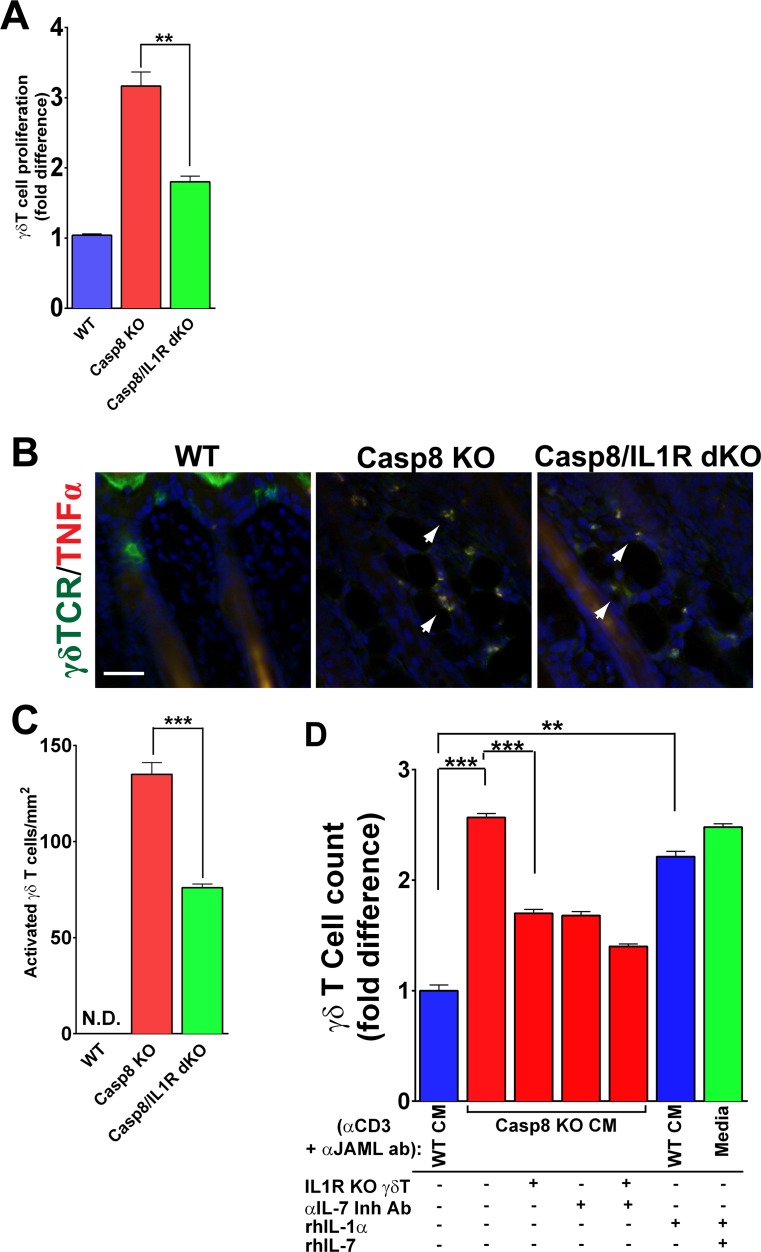
IL-1 signaling contributes to γδT-cell proliferation in the caspase-8 cKO skin.(A) Quantification of γδT-cell proliferation. The numbers of γδT-cells are reported as the fold difference from WT, which was normalized to 1. **p<0.001. (B) Detection of activated γδT-cells. γδT-cell (green) activation was monitored by expression of TNFα (red) via immunofluorescence. Nuclei (blue) are stained with DAPI. Arrowheads mark some of the activated γδT-cells. (C) Quantification of activated γδT-cells per square millimeter. Scale bar = 50 µm, ***p<0.0001. (D) Recapitulation of γδT-cell proliferation in vitro. Primary γδT-cells were isolated from the skin of either wild type (WT) or IL1R knockout mice (IL1R−/− γδT-cell), primed with anti-CD3 and anti-JAML and treated with conditioned media from WT (WT CM) or caspase-8 conditional knockout (C8 KO CM) skins. Inhibitory antibody against IL-7 or recombinant human IL-1α or IL-7 were added as indicated. The histogram shows the fold difference in γδT-cell numbers relative to numbers of WT CM-treated γδT-cells, which are normalized to 1. Data are representative of at least three independent experiments performed in triplicate. **p<0.001, ***p<0.0001.